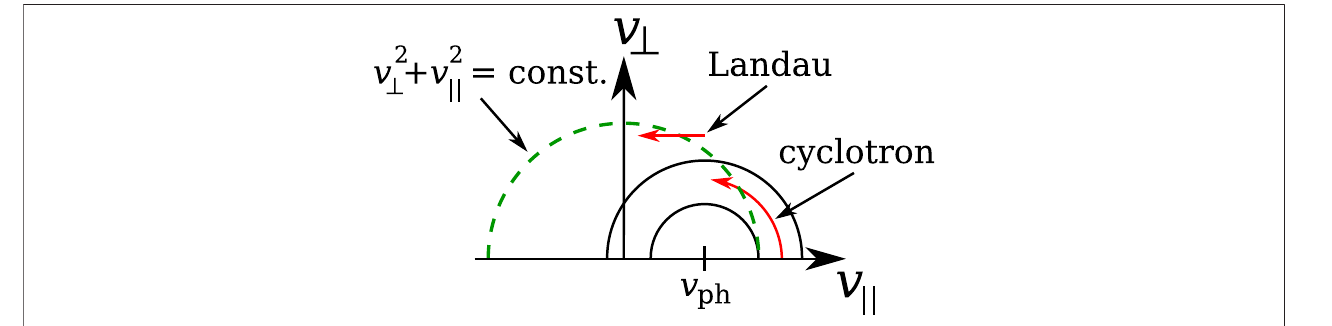
FIGURE 3 | Schematic illustration of quasi-linear diffusion in velocity space. The black semi-circles represent Eq. 17 for a given parallel phase speed v ph . The diffusive fl ux of resonant particles is locally tangent to these semi-circles (marked by the red arrows). The green-dashed semi-circle indicates v 2 ⊥ + v 2 (cid:2) (cid:3) constant. If the diffusive fl ux crosses the green-dashed semi-circle from larger to smaller values of ( v 2 ⊥ + v 2 (cid:2) ) , the resonant wave – particle interaction contributes to the growth of the resonant waves with parallel phase speed v ph . Examples for Landau-resonant and cyclotron-resonant interactions are